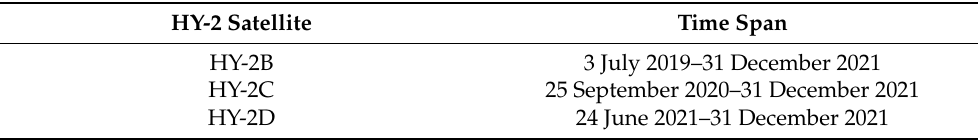
Table 2. Summary of HY-2B/C/D Level 2B wind vector products used for evaluation and